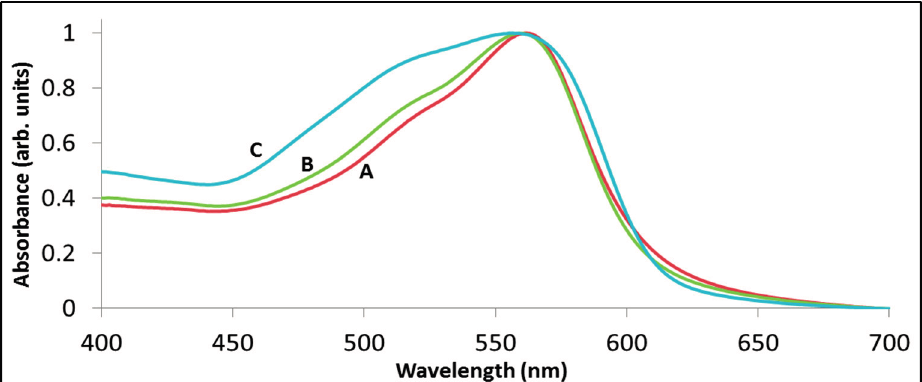
Figure 7. Changes in the absorption spectrum of rhodamine B pre-adsorbed on BiOCl from aqueous solutions containing various dye concentrations. For clarity, all graphs were normalized. (A) 0.5 mg/L; (B) 1.5 mg/L; (C) 15